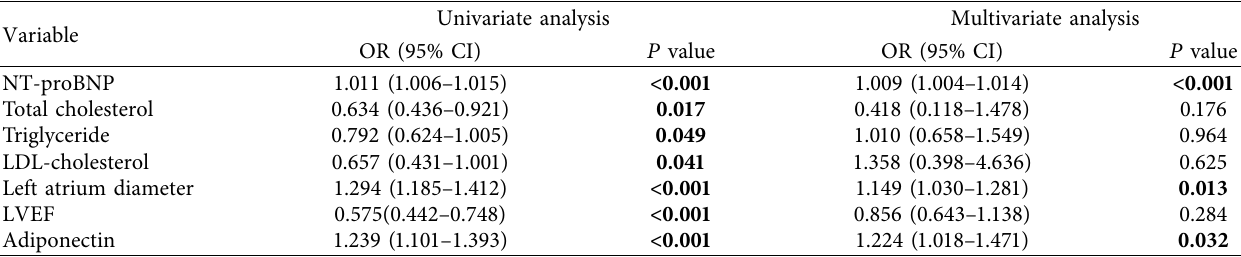
Table 3: Univariate and multivariate logistic regression analysis for the independent predictors of AF.